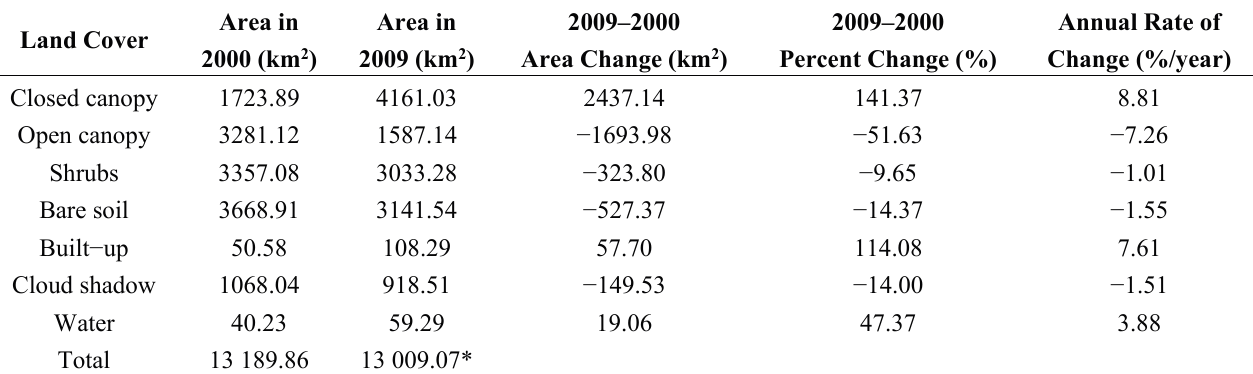
Table 3. Land-cover change in the region, 2000–2009.